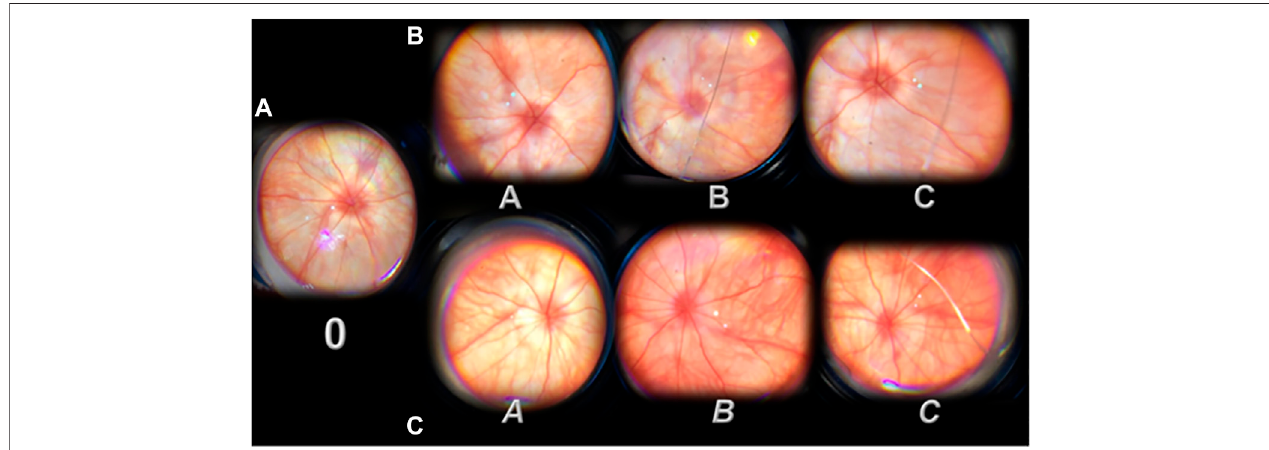
FIGURE3| Presentation oftheratretinaafterretrobulbar administered L-NAME(periodfrom20 minutestillthe1 day)before(0, (A) )and aftertherapy[saline(A, B, and C; (B) ); BPC 157 (A, B, and C; (C) )] administration. 0, L-NAME point before therapy application, at 20 min after retrobulbar administered L-NAME. Moderate generalized irregularity diameter blood vessels with moderate atrophy ofthe optic disk, faint presentation of the choroidal blood vessels (A) . Aftertherapy application (A, B, and C(saline) or A, B, and C(BPC 157)) (B,C) . Immediatelyafter (A, A ).A. Strong generalized irregularity diameter blood vessels with severe atrophy ofthe optic disc,extremelypoorpresentationofthechoroidalbloodvessels(saline, B ). A. Discretegeneralizedirregularity diameterblood vessels withmildatrophyoftheopticdisc, normal presentation ofthe choroidal blood vessels(BPC 157, C ). 20 min after (B, B ).B. Strong generalized irregularity diameter blood vessels with severe atrophy ofthe optic disc, extremely poor presentation of the choroidal blood vessels (saline, B ). B. Normal eye background, normal presentation of the choroidal blood vessels (BPC 157, B,C ). 1 day after (C, C ). C. Strong generalized irregularity diameter blood vessels with severe atrophy of the optic disc, extremely poor presentation of the